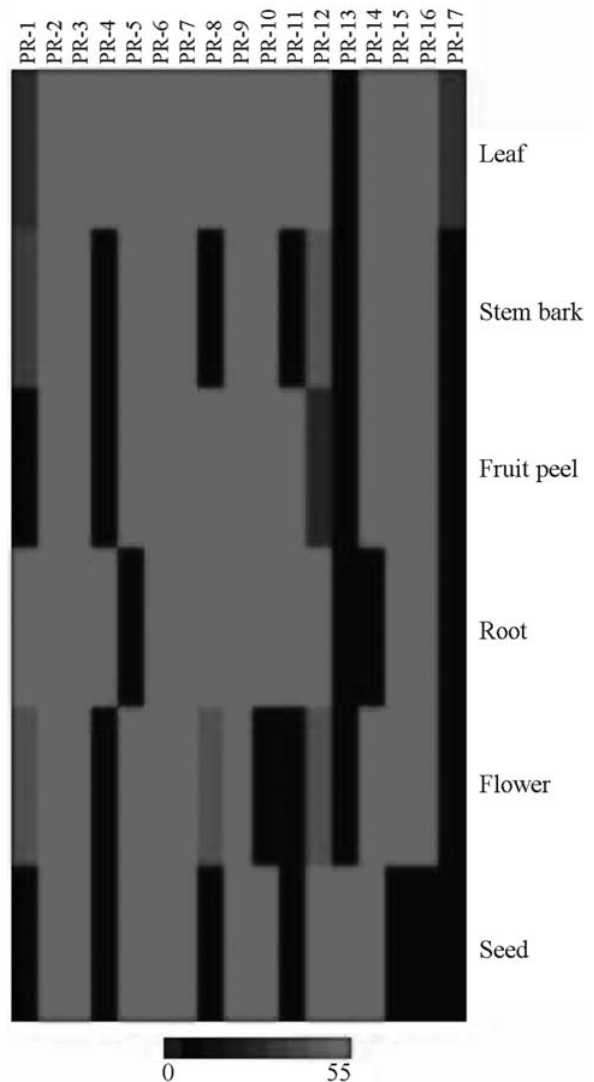
Figure 4 - Graphical representation of the expression profiles of putative PR genefamilies(PR-1toPR-17)indifferentcitrusorgancDNAlibraries. Data represent the relative number of PR reads from a specific library in each EST-contig per 1,000 reads. Each organ library is represented by a single row; each PR gene family is represented by a single